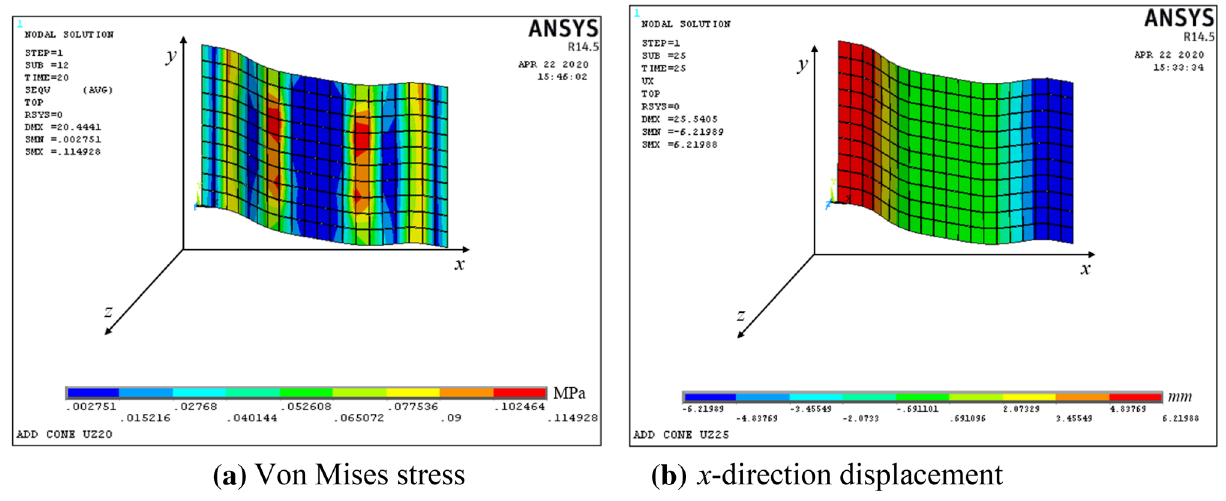
Fig. 5 Distribution of stress and x -direction displacement when L